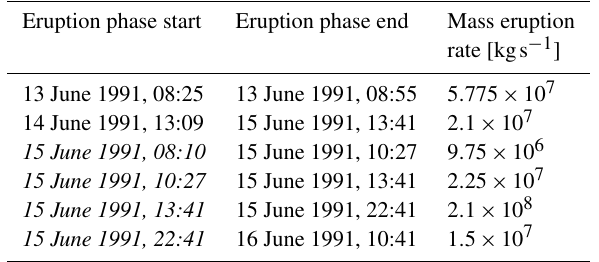
Table 1. Eruption phases implemented in the right-hand side. For time periods not listed in this Table, the right-hand side was set to zero. The values given in italics are those for the climactic phase of the eruption. For converting m 3 s − 1 to kgs − 1 we used an average density of 1500kgm − 3 .